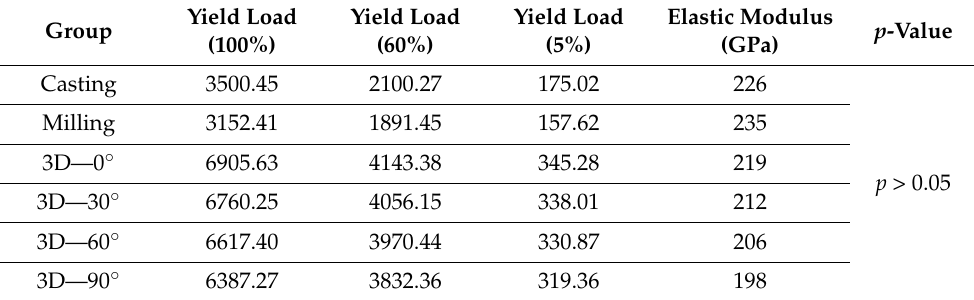
Table 3. Elastic modulus result value of tensile strain method measured through 0.2% yield strength. Yield Load Group